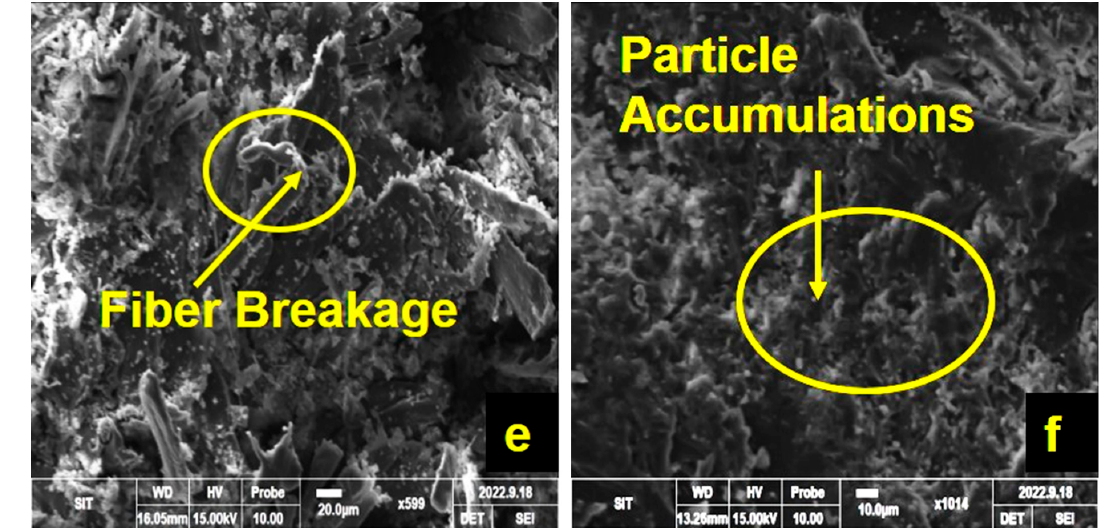
Figure 7. Microstructural examination of the 4% OPS filler/flax/epoxy based hybrid composites under aa ( a ) 15 min and ( b ) 30 min cryogenic environment; ( c ) 0 wt.% OPS; ( d ) 2 wt.% OPS; ( e ) 4 wt.% OPS; and ( f ) 6 wt.% of OPS based ILSS composite after fracture at 30 min cryogenic treatment.